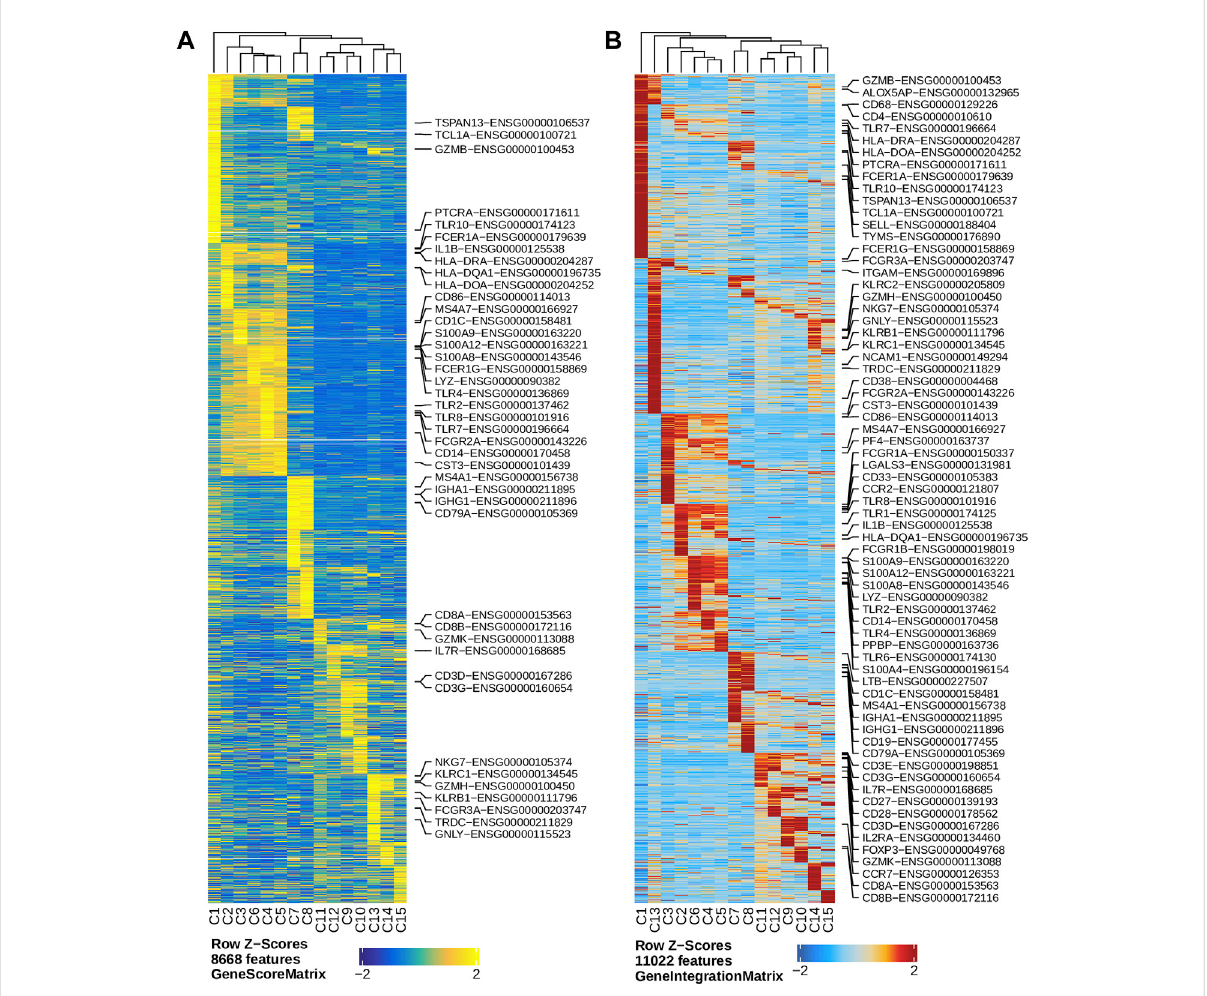
FIGURE 3 Marker genes across clusters identi fi ed in the human PBMC scATAC-seq data. (A) Heatmap showing standardized gene scores (Z-scores) of 8,668 marker genes across the 15 clusters. (B) Heatmap showing standardized pseudo expression (Z-scores) of marker genes across the 15 clusters. Known marker genes in the form of gene symbol-Ensembl ID are labelled on the right of each